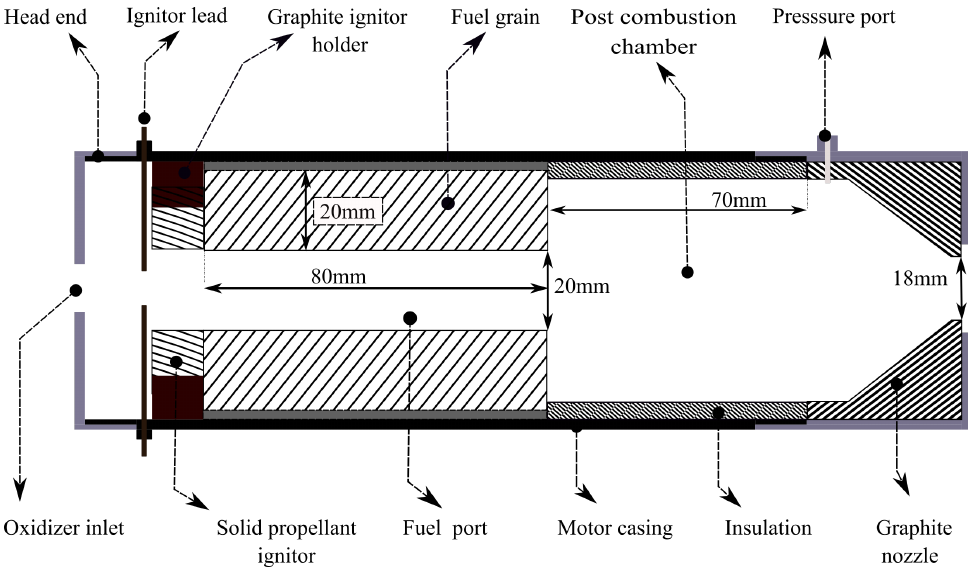
Figure 2. Schematic of the hybrid rocket